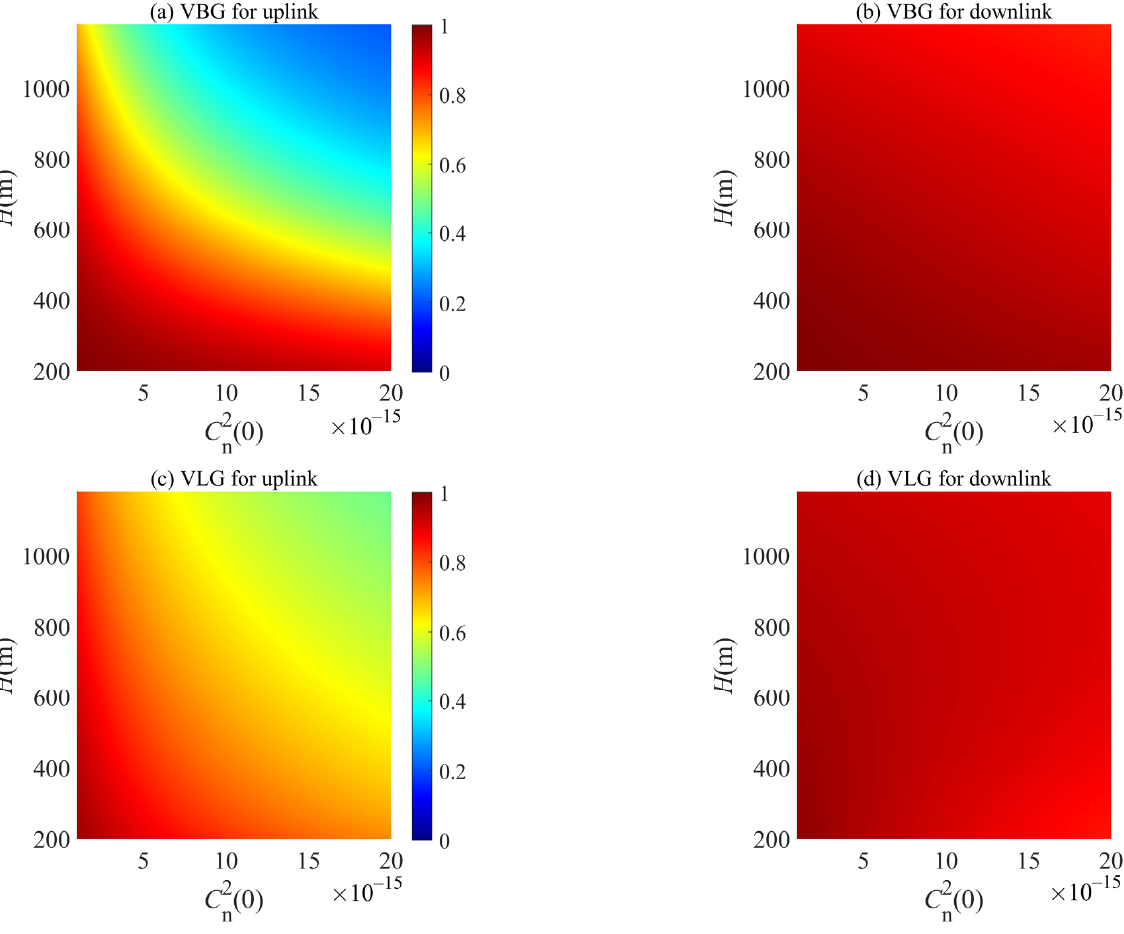
Figure 7. Signal mode detection probability of vector vortex beams versus H and C 2 n ( 0 ) for uplink ( a , c ) and downlink ( b , d ) atmospheric turbulence transmissions.